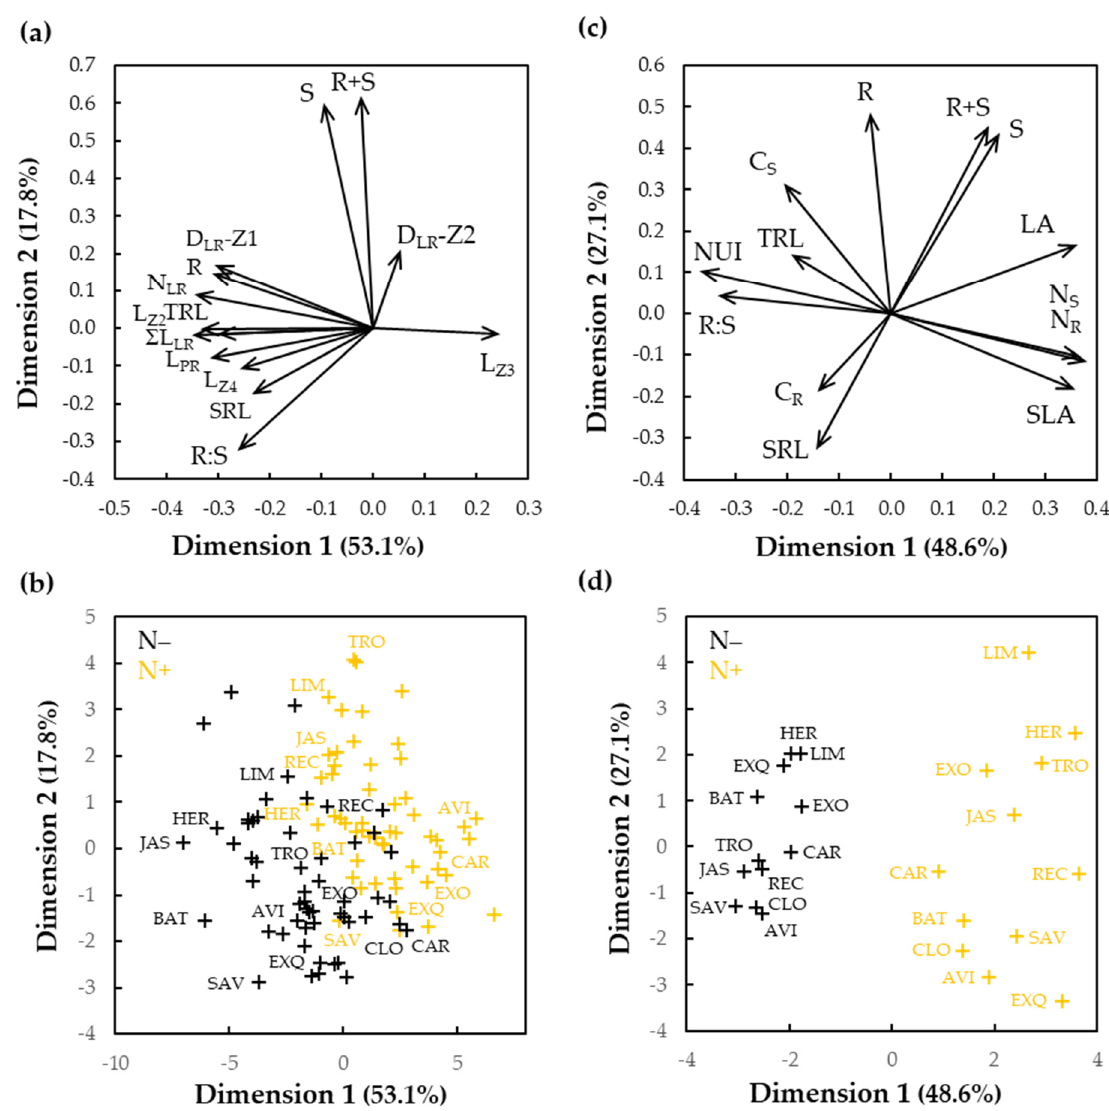
Figure 4. Principal component analysis of 14 phenotypic traits measured in 55 oilseed rape cultivars cultivated in vitro ( a , b ) and of 13 phenotypic traits in 12 cultivars in hydroponics ( c , d ). ( a , c ) Principal component (PC) biplot showing the compositions of the first two PCs, with cumulative variance; ( b , d ) Representation of the cultivars. Symbols indicate position of the cultivars as determined by their trait values in the two first PCs. Black symbols refer to low nitrate (N − ) and yellow symbols to high nitrate (N+) conditions. Traits are defined in Table 1 and cultivars listed in Table S1.